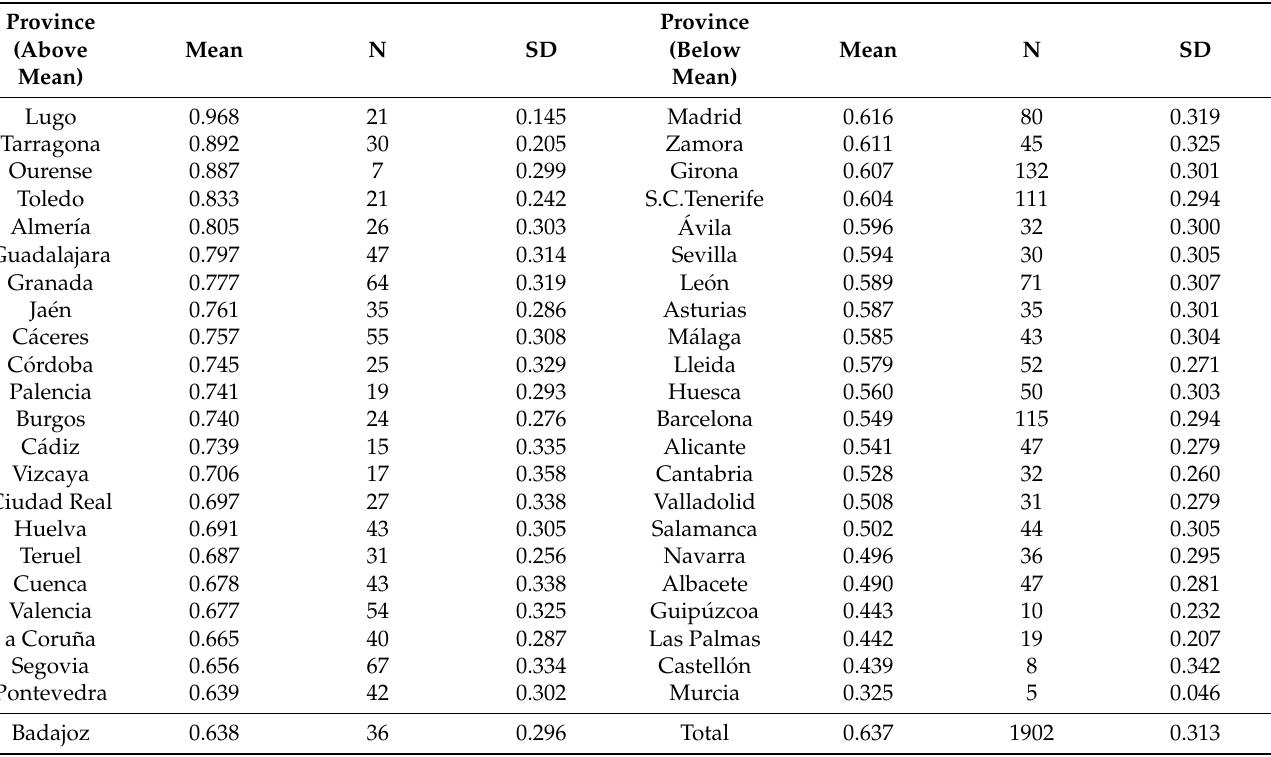
Table 9. Efficiency results by province in rural tourism destinations.